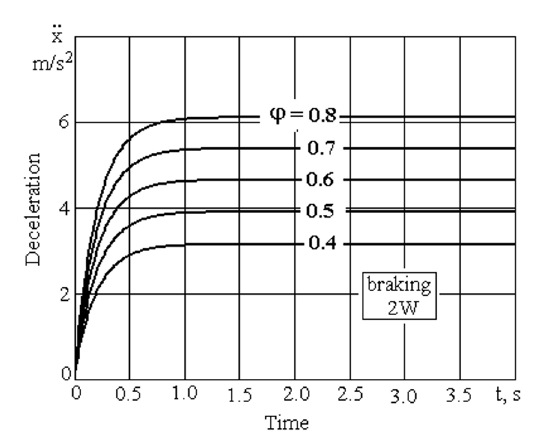
Figure 4. Variation of tractor speed during braking taking into ac- count the time, for 5 values of the coefficient of road ad-